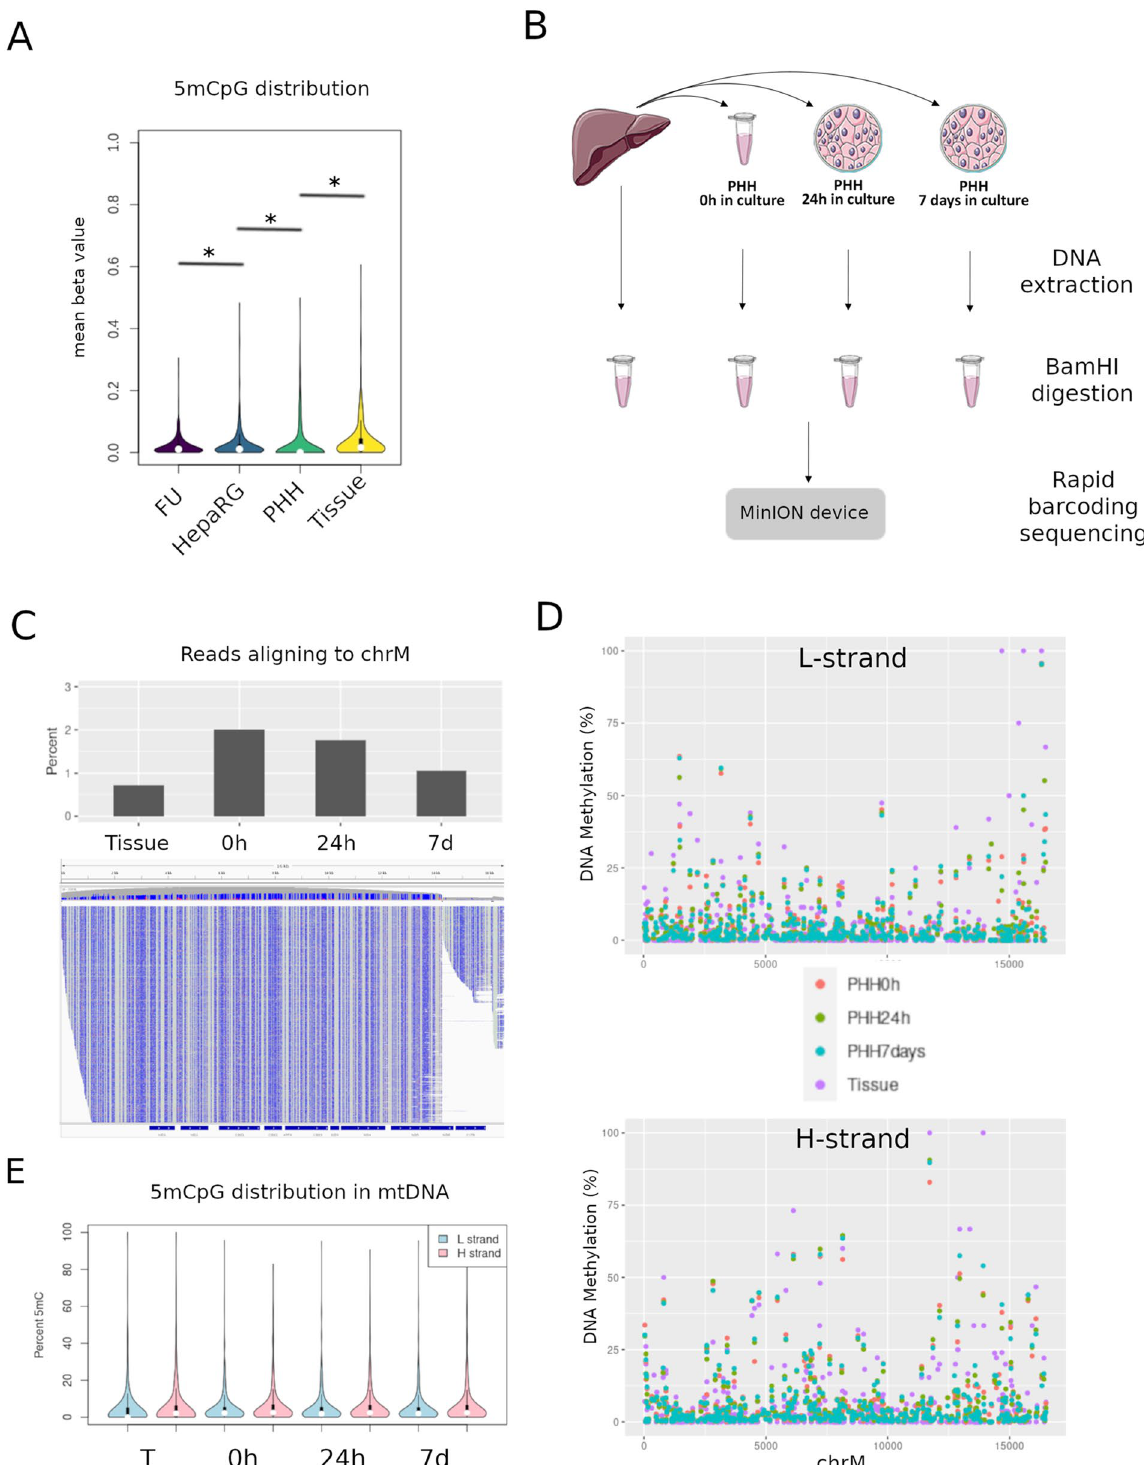
Figure 5. Hepatocyte methylation upon cell culture. ( A ) 5mCpG distribution along mtDNA for fully unmethylated control (FU), proliferative HepaRG cells, primary human hepatocytes (PHH) and one representative non-tumor liver tissue (Tissue). (*) indicates p value < 0.05, Mann–Whitney’ test. ( B ) mtDNA DNA methylation after hepatocyte isolation and culture conditions in a kinetics experiment. ( B ) Experimental overview, PHH were isolated form healthy liver tissue and cultured for 0 h, 24 h or 7 days before DNA extraction and sequencing with Nanopore. ( C ) Percentage of reads aligning to the chrM for each sample (upper panel), and visualization of aligned reads to chrM in IGV (lower panel), reads converted to identify 5mCpG (blue = unmethylated cytosine, red = methylated cytosine). ( D ) Base level 5mCpG on L-strand (upper panel) and H-strand (lower panel) in each sample. ( E ) 5mCpG distribution of L and H strands between each sample and time